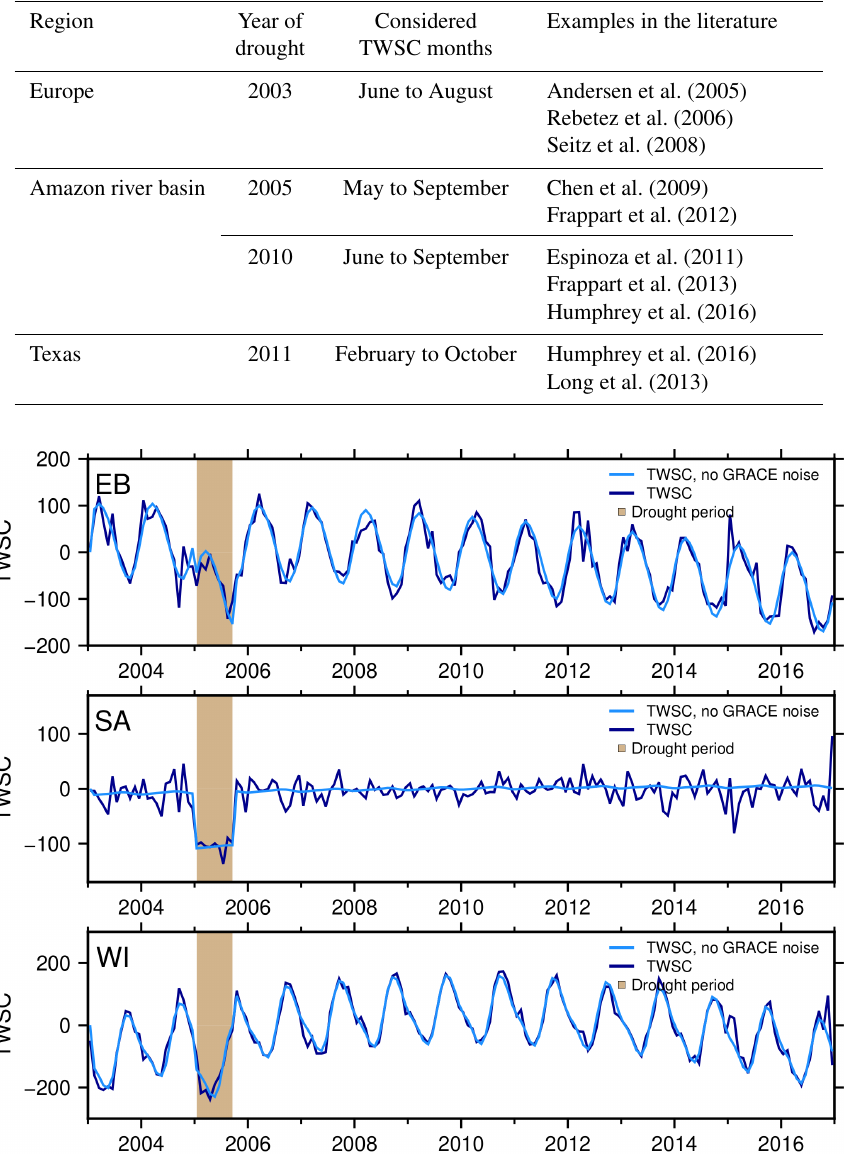
Table 4. Drought events in Europe, the Amazon river basin, and Texas with corresponding duration taken from the literature.